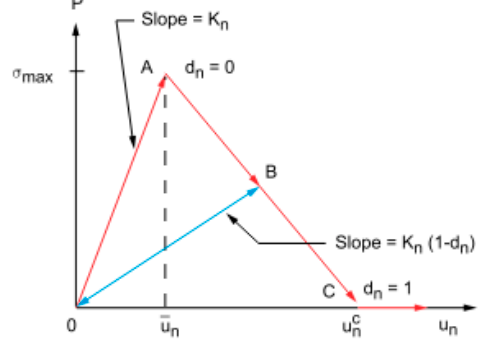
Figure 4. Normal contact stress and contact gap curve for bilinear cohesive zone material .